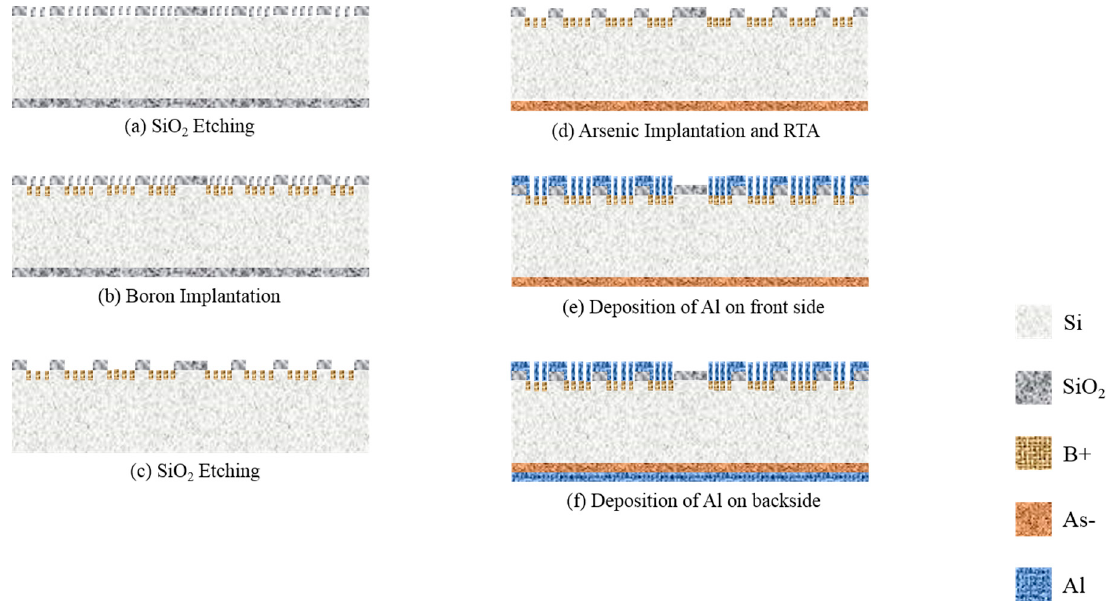
Figure 3. The schematic fabrication processes of the MA-Al BSE detector. ( a ) Front side working areas. A 500 nm-silicon dioxide layer is etched. ( b ) Ion implantation of finger structure by boron ions on front side. ( c ) A 500 nm-silicon dioxide on backside is etched. ( d ) Backside ion implantation by arsenic ions and then RTA treatment at 950 °C for 60 s. ( e ) A 600 nm-aluminum grids film is deposited on front side. ( f ) A 600 nm-aluminum layer is deposited on backside.